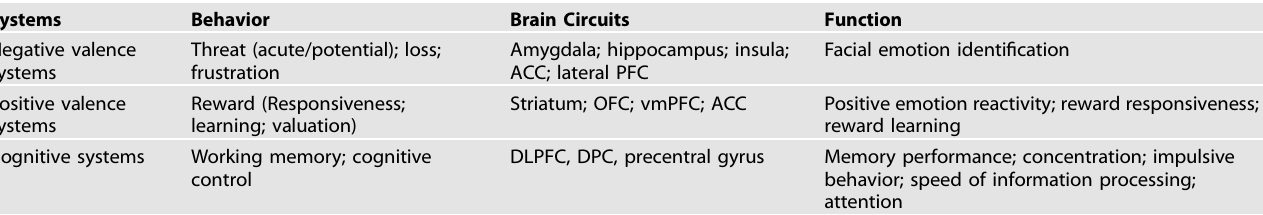
Table 3. The negative/positive valence systems and cognitive